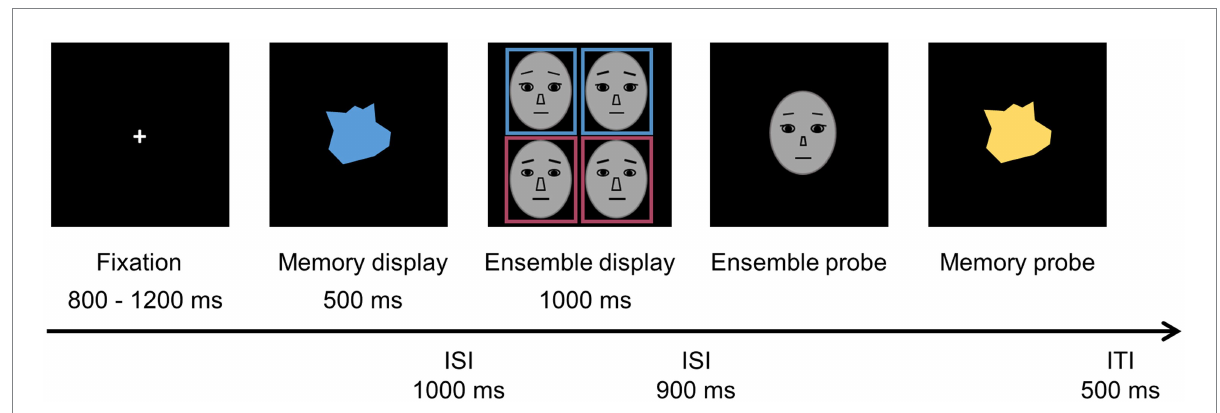
FIGURE 4 Sequence of the display in Experiment 2, with the identical procedure and task requirements as Experiment